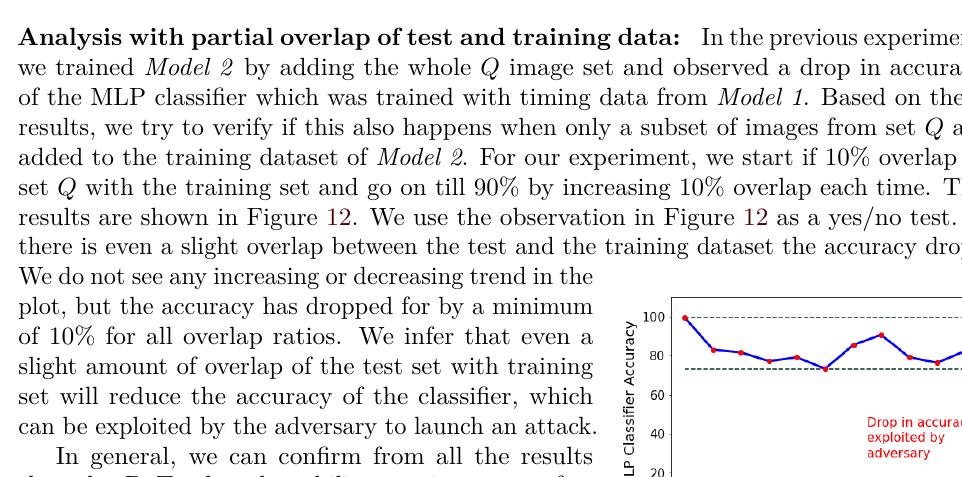
Figure 11: Bypassing Differential Privacy